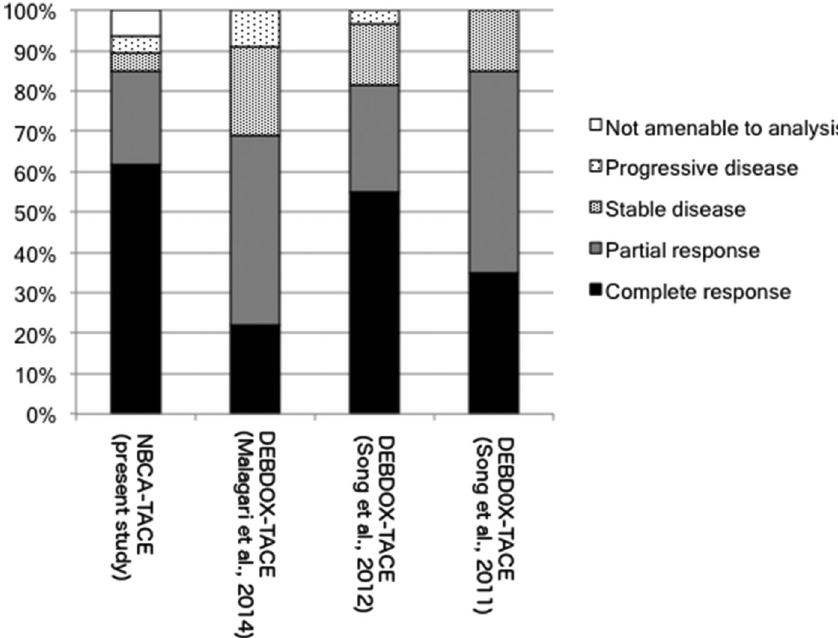
Figure 6 - Radiological responses assessed by mRECIST found in the present study compared to other studies in the